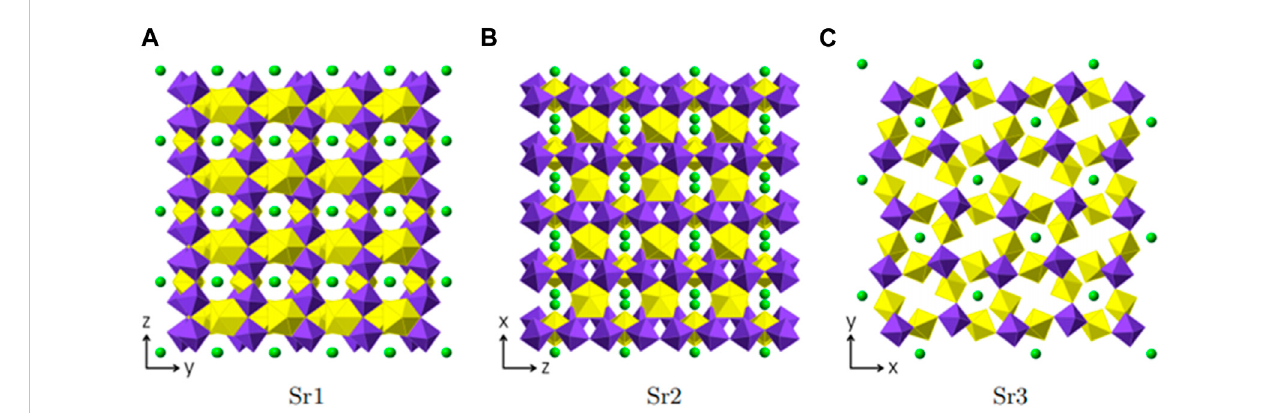
FIGURE 6 Sr positions within Sr [(UO 2 ) (TeO 5 )] depicted in green. Each fi gure shows the complete uranyl tellurate framework with only the according Sr 2+ positions depicted. (A) Srl -view ⊥ [100], (B) Sr2-view ⊥ [010] and (C) Sr3-view ⊥